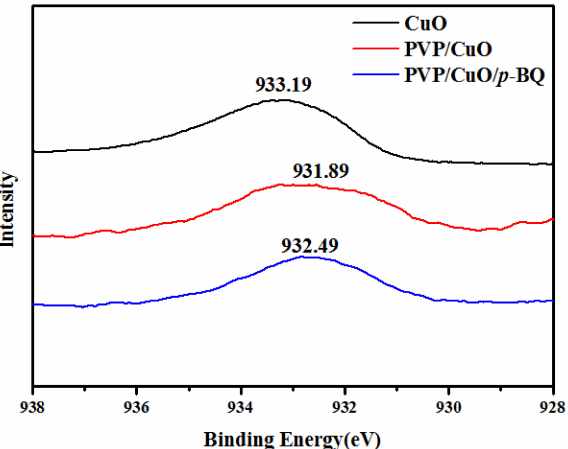
Figure 6. The binding energy of copper with CuO, PVP/CuO, and PVP/CuO/ p -BQ